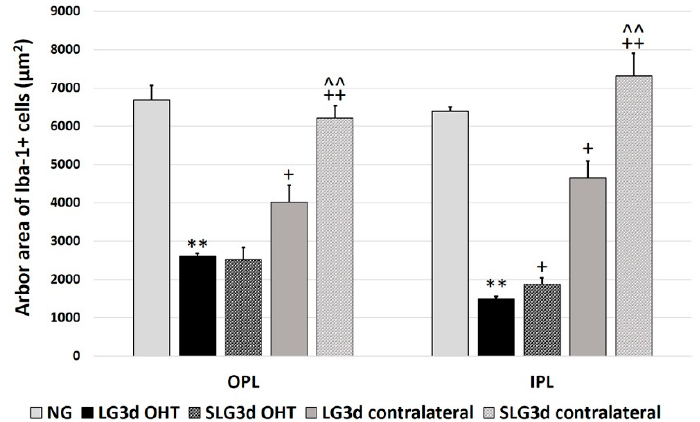
Figure 7. Comparison of the arbor area of Iba-1 + cells in the outer plexiform layer (OPL) and inner plexiform layer (IPL) in eyes untreated and treated with saffron extract at 3 days after ocular hypertension (OHT) induction. Histograms show the mean arbor area (± standard deviation, SD) of Iba-1 + cells. Abbreviations: Naïve age-matched control (NG), lasered group contralateral (LG3d contralateral), lasered group ocular hypertension (LG3d OHT), lasered group contralateral + saffron (SLG3d contralateral), lasered group ocular hypertension + saffron (SLG3d OHT). Statistical significance indicators: ** p < 0.01; vs. NG. + p < 0.05, ++ p < 0.01; vs. LG3d OHT. ^^ p < 0.01; vs. LG3d contralateral.